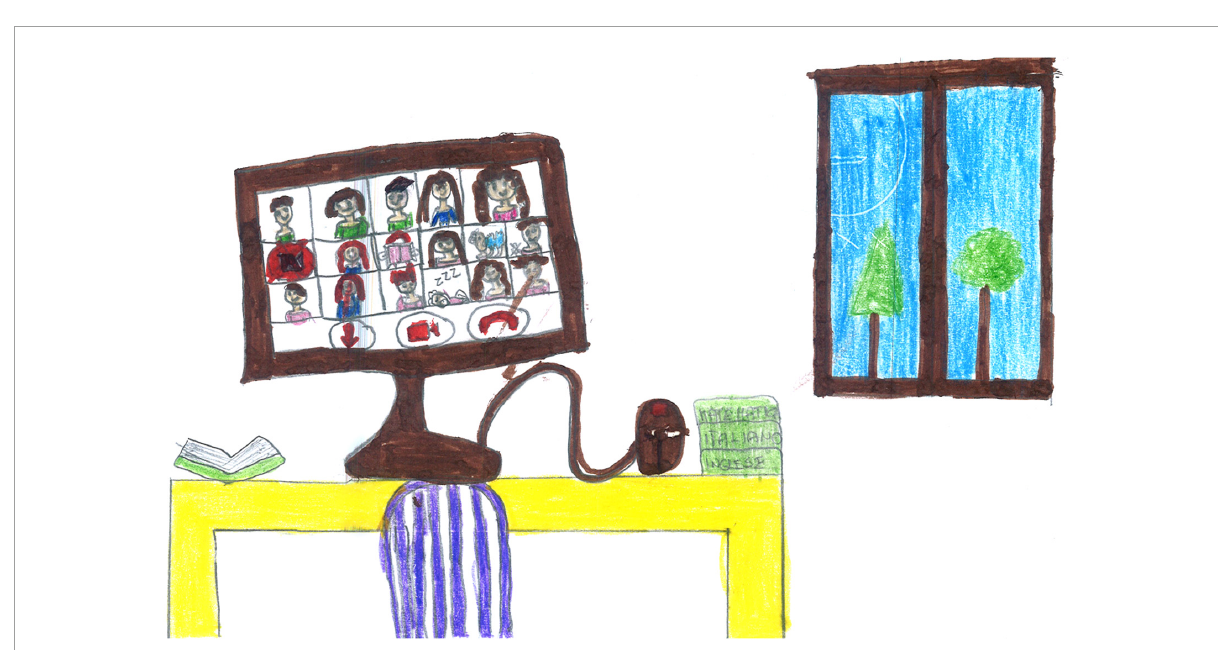
FIGURE12 Distant learning, but the girls’ own chair is empty (SS, Female, 11